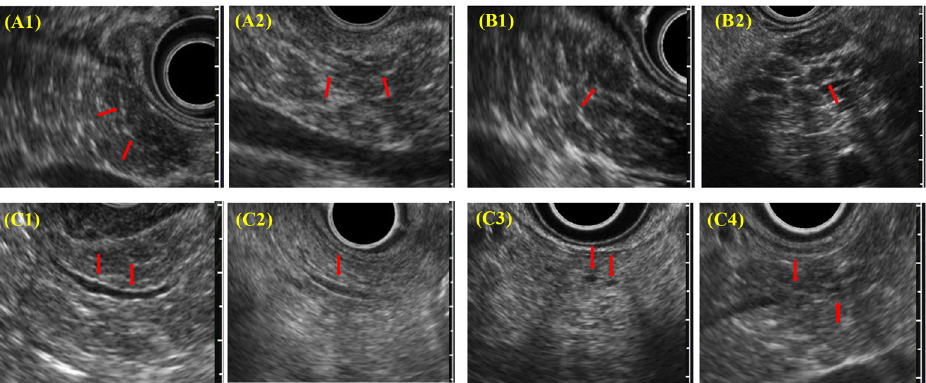
Figure 3. Each EUS finding in DCECP2019; ( A1 , A2 ) hyperechoic foci; nonshadowing/stranding; ( B1 , B2 ) lobularity (nonhoneycombing/honeycombing type); ( C1 , C2 ) hyperechoic MPD margins; ( C3 , C4 ) dilated side